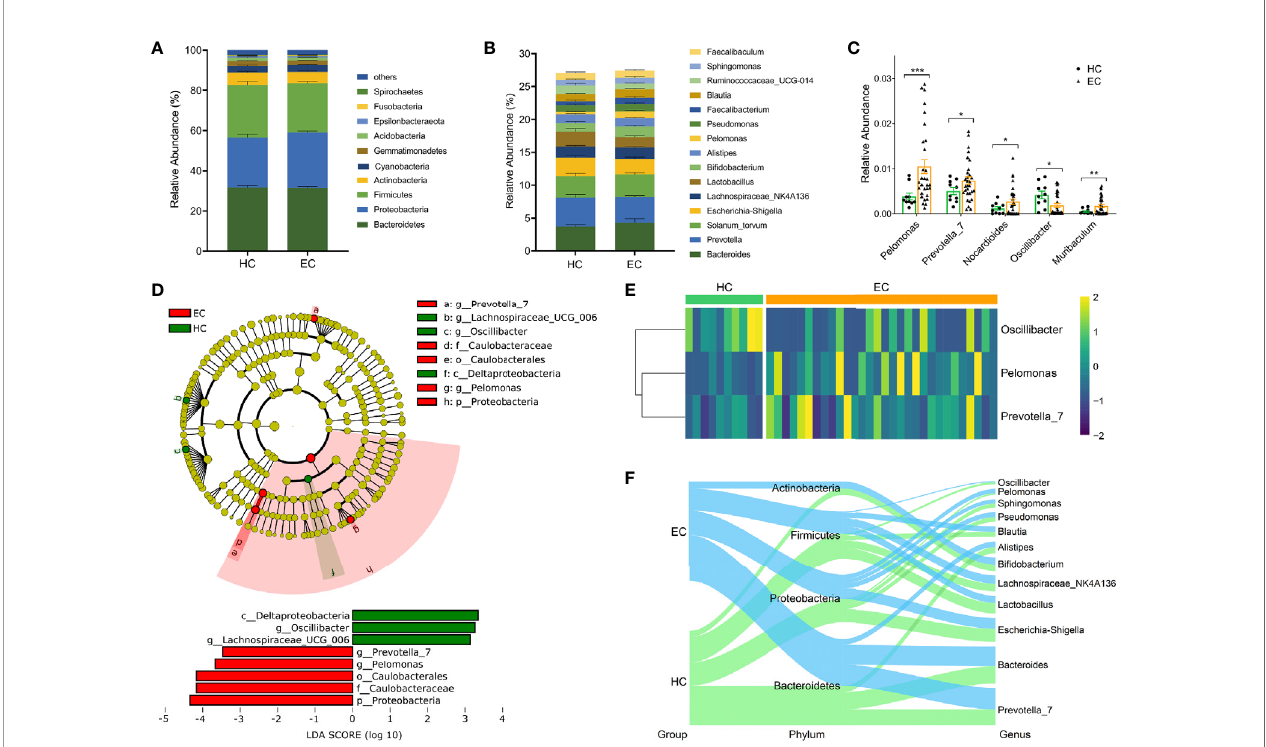
FIGURE 2 | Phylogenetic pro fi les of endometrial microbiota between the HC and EC groups. (A) Compositions of the bacterial community at the phylum level between HC and EC. (B) Compositions of the bacterial community (top 15) at the genus level between HC and EC. (C) Differential microbial community at the genus level in EC versus HC. Error bars are presented as the SD. (D) LEfSe analysis for comparing microbial variations in HC and EC at the genus level. LEfSe cladogram representing differentially abundant taxa ( p < 0.05); LDA scores are calculated based on the LEfSe of differentially abundant taxa among groups, and only taxa with LDA scores of > 3 are presented. (E) Distributions of Oscillibacter , Pelomonas , and Prevotella normalized by a Z -score between HC and EC. (F) Sankey analysis of HC and EC. *p < 0.05, **p < 0.01, ***p < 0.001.